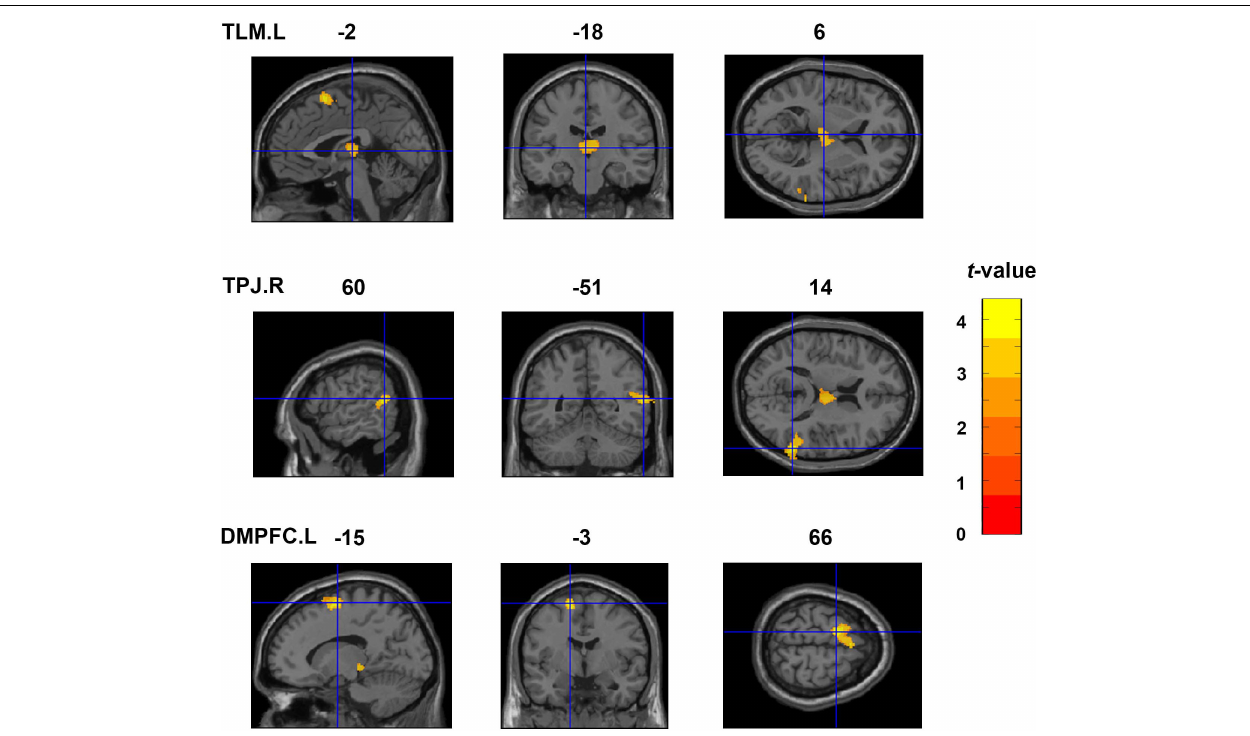
FIGURE 2 | Whole-brain VBM analyses showing three clusters exhibiting significant and positive correlations with the IES (an index of dispositional insight). These clusters include the TLM.L, TPJ.R, and DMPFC.L. Coordinates are shown in the MNI space. TLM.L, left thalamus; TPJ.R, right temporoparietal junction; DMPFC.L, left dorsal medial prefrontal cortex; VBM, voxel-based morphometry; IES, inverse efficiency score; MNI, Montreal Neurological